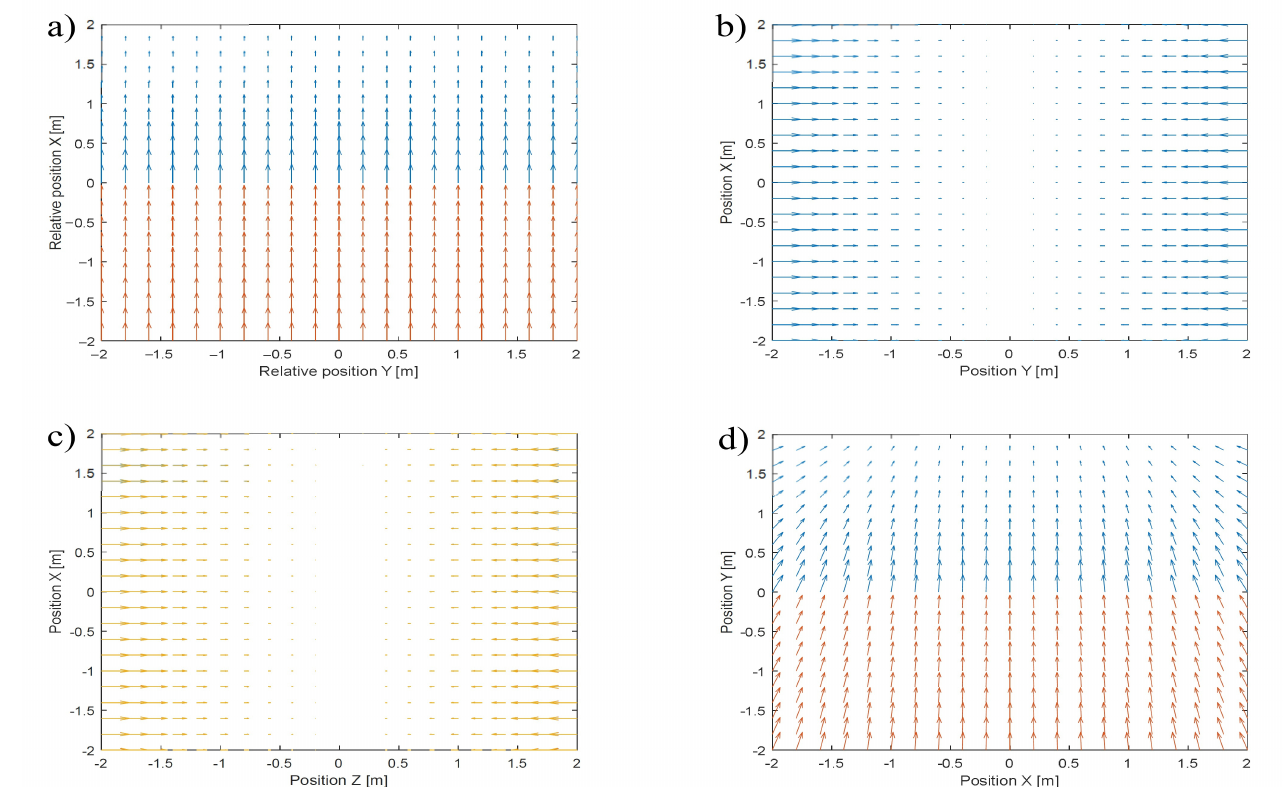
Figure 1. Velocity vector subfields, components of the velocity vector field defined around: ( a ) axis x , a cross-section in the plane x - y , ( b ) axis y , a cross-section in the plane x - y , ( c ) axis z , a cross-section in the plane x - z , ( d ) the velocity vector field based on APF as a superposition of subfields ( a – c ) (a cross-section in plane x - y